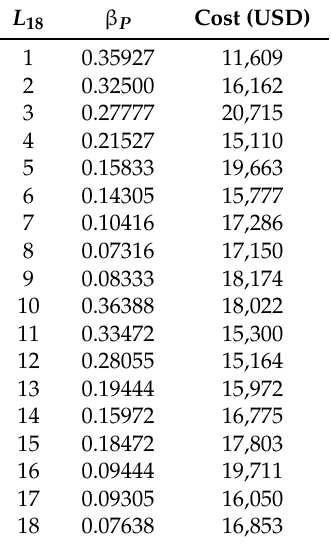
Table 4. This research’s level and design factor table.